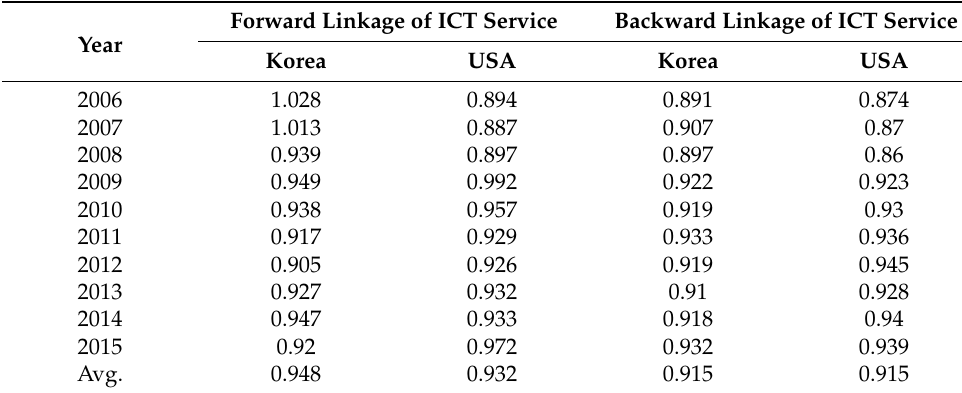
Table 9. Comparison of linkage effects of ICT Service between Korea and USA.